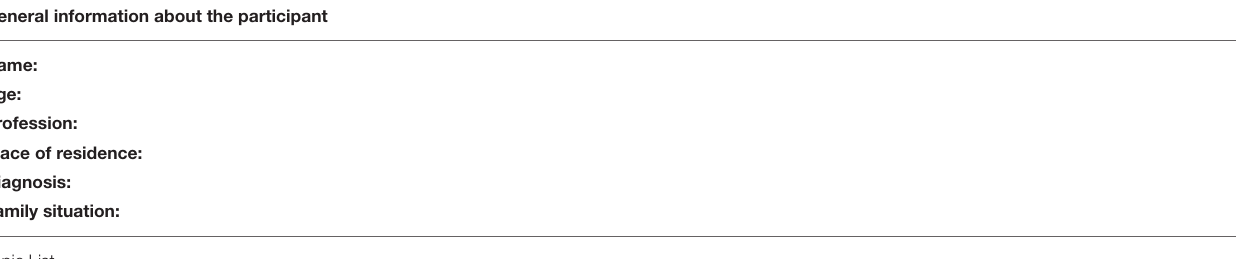
TABLE 1 | Semi-structured interview guide. General information about the